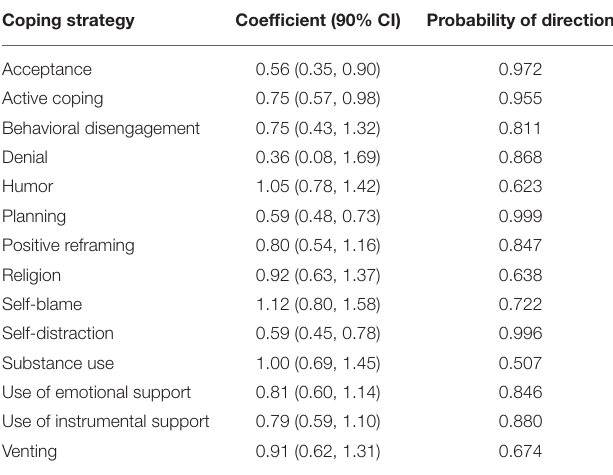
TABLE 1 | Coefficients and probability of direction associated with event day